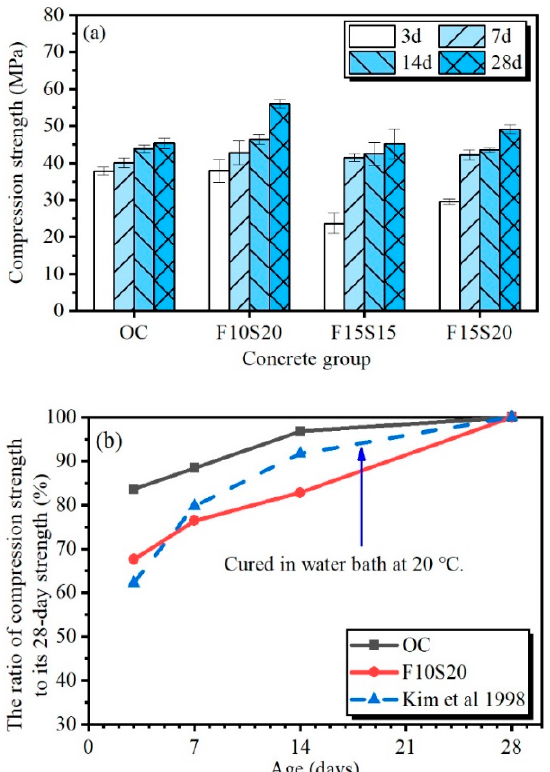
Figure 4. The compression strength of concrete: ( a ) The compression strength of the four types of concrete with curing age; ( b ) The ratio of compression strength to its 28-day values with curing age.